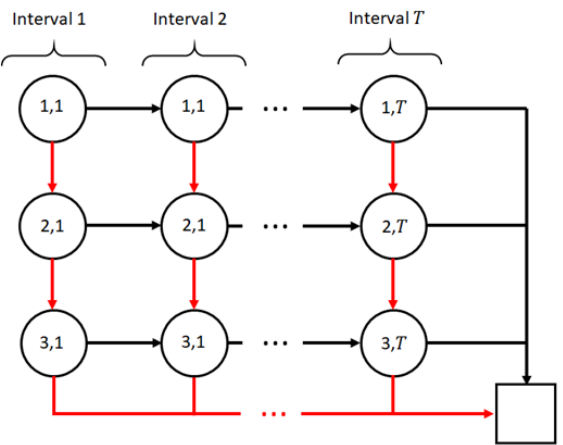
Figure 2. Hydrothermal Coordination modeling using Network